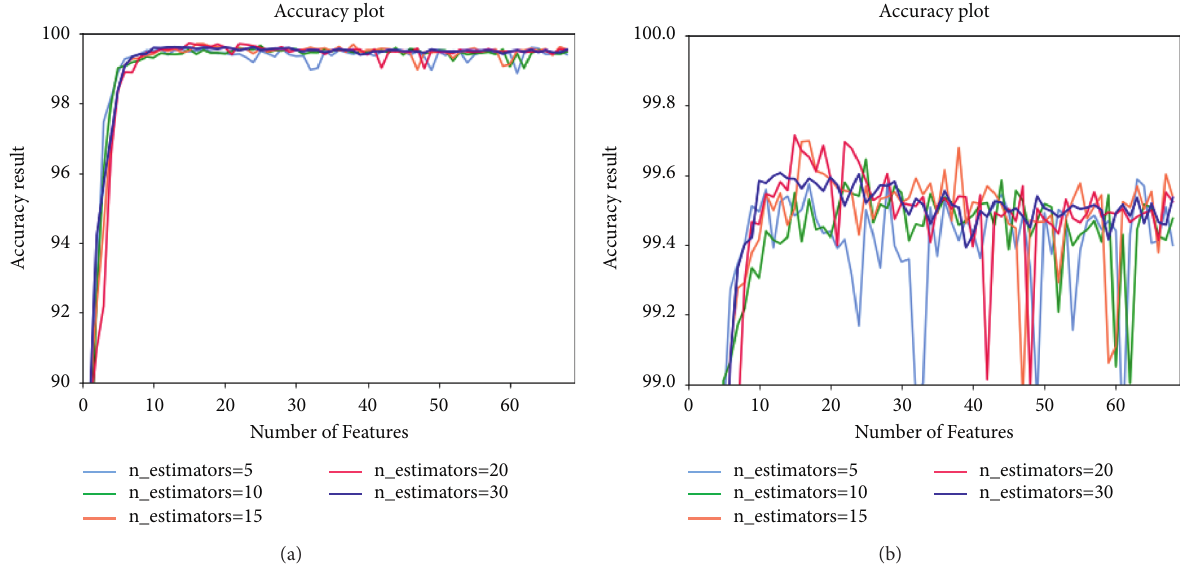
Figure 7: Cross-validated accuracy result on CICIDS2017-Wed1 dataset. (a) Accuracy score above 90%. (b). Accuracy score above 99%.